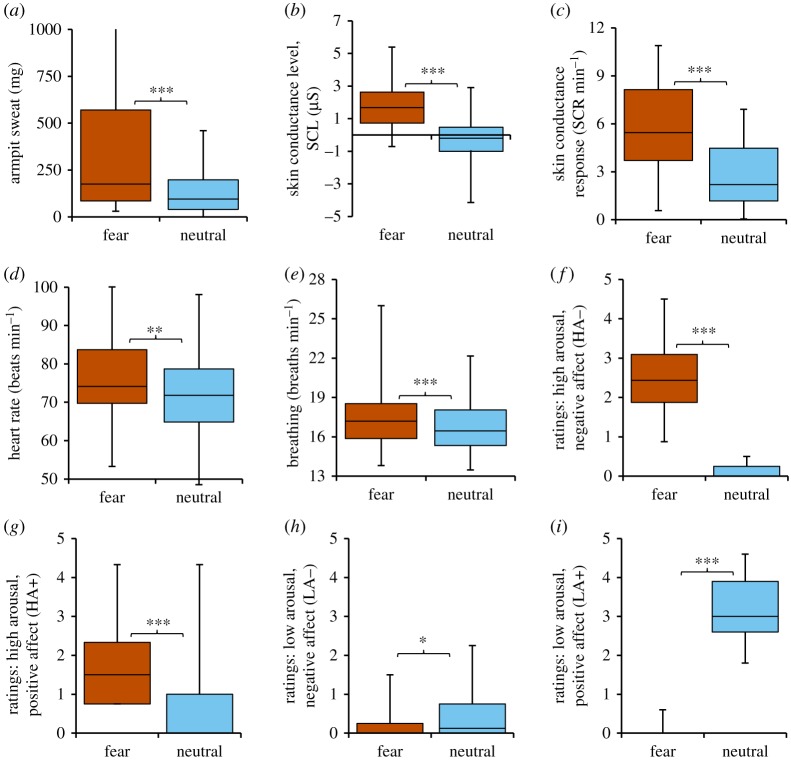
Univariate results showing effective fear induction on physiological and subjective measures. Boxplots display the distribution of the data, their full range from minimum to maximum (whiskers), the 25–75% range (box), and the median (middle of the box). Significance: *p < 0.05, **p < 0.01, ***p < 0.001. (Online version in colour.)